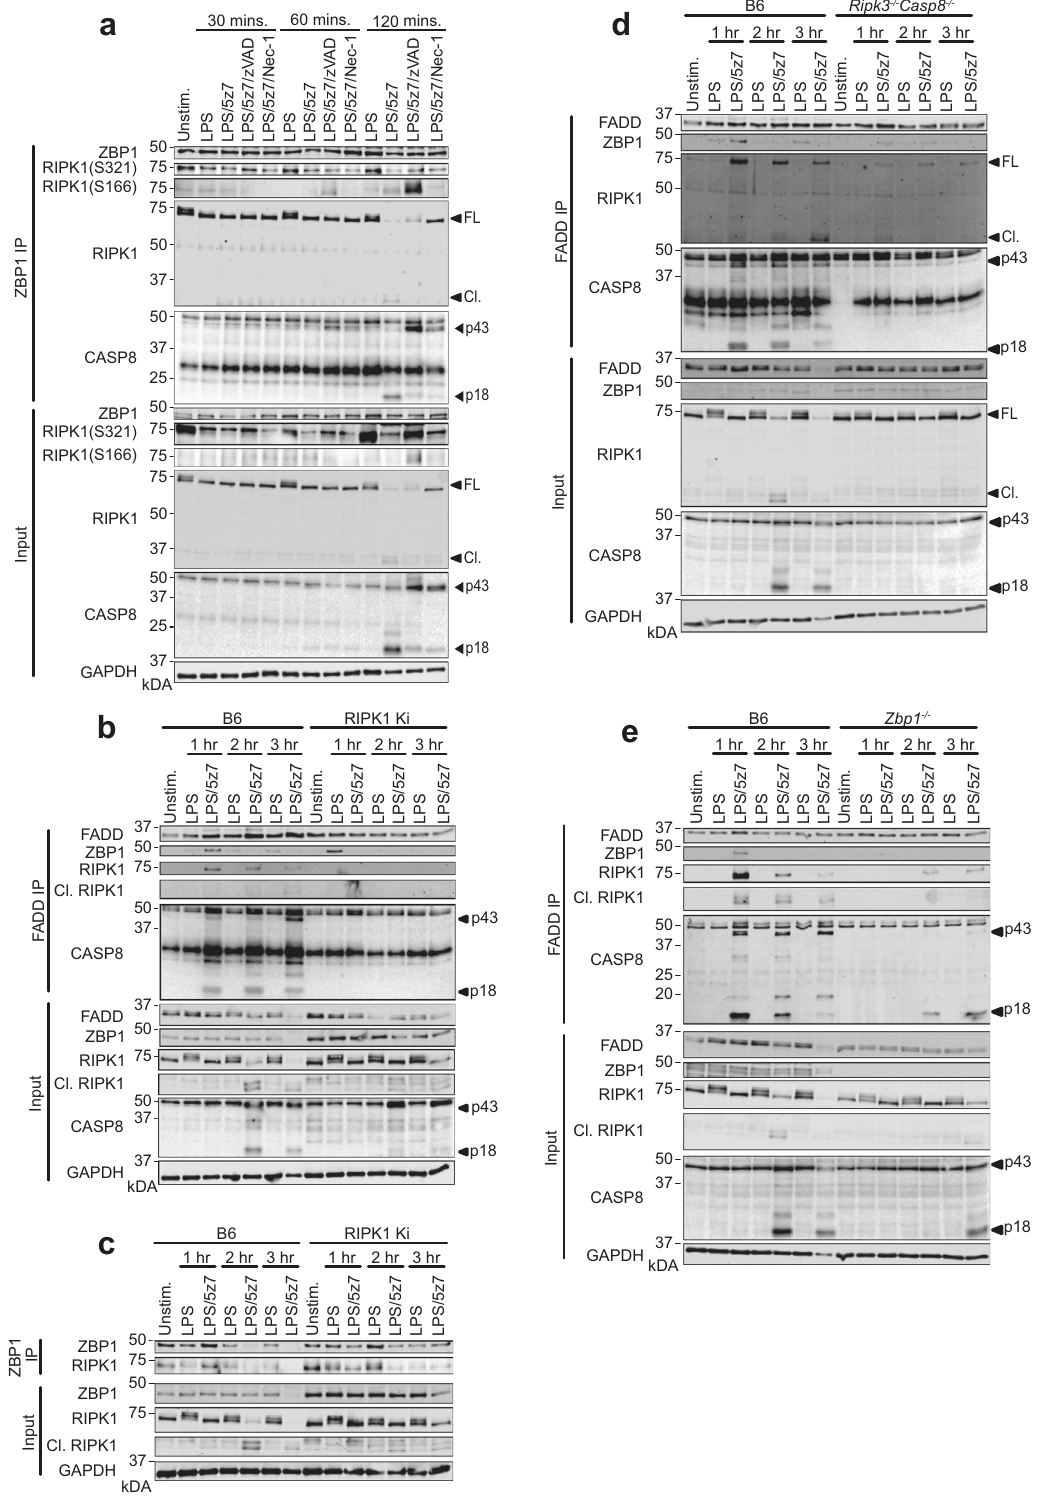
Fig. 5 ZBP1 and RIPK1 kinase activity regulate TRIFosome formation. a ZBP1 immunoprecipitation in B6 BMDMs stimulated as indicated and probed for RIPK1 and CASP8. b FADD and c ZBP1 immunoprecipitations in B6 and RIPK1 kinase-inactive BMDMs stimulated as indicated and probed for ZBP1, RIPK1, and CASP8. d , e FADD immunoprecipitation in B6, d Ripk3 − / − Casp8 − / − , or e Zbp1 − / − BMDMs stimulated as indicated and probed for ZBP1, RIPK1,